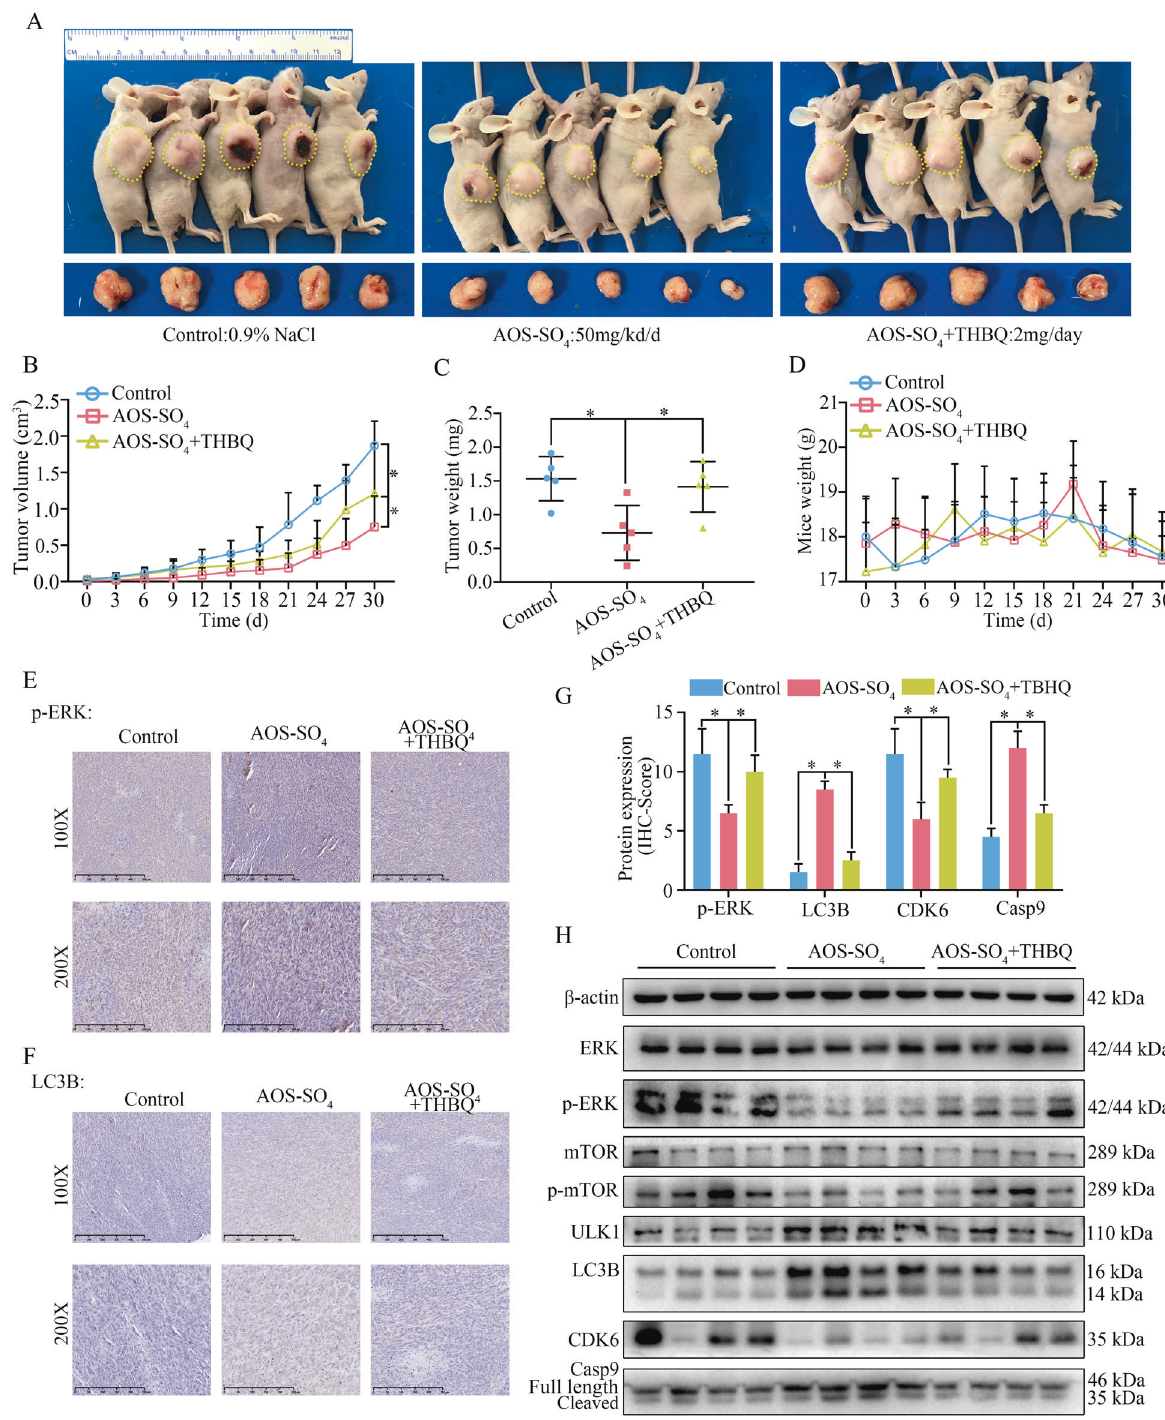
Fig. 6 AOS-SO 4 inhibits osteosarcoma cell growth through the MEK1/ERK/mTOR pathway in vivo. A Photograph of tumor-bearing mice and photograph of tumors after the mice were euthanized in the control group, AOS-SO 4 group and AOS-SO 4 + THBQ group. B Growth curve drawn by measuring tumor volumes on the indicated days. C Diagram showing the tumor weights in the subcutaneous tumor model. D Diagram showing the mouse weight in the subcutaneous tumor model. E, F Representative images of p-ERK and LC3B staining in the subcutaneous tumor model. G The quanti fi cation of IHC staining about the protein expression of p-ERK, LC3B, CDK6, and Casp9. H Protein levels of proliferation, apoptosis, autophagy, and phosphorylated ERK and mTOR in tumor tissues in the three groups. Statistical analysis was performed using Student ’ s t-test. Error bars represent the SEM. * P <